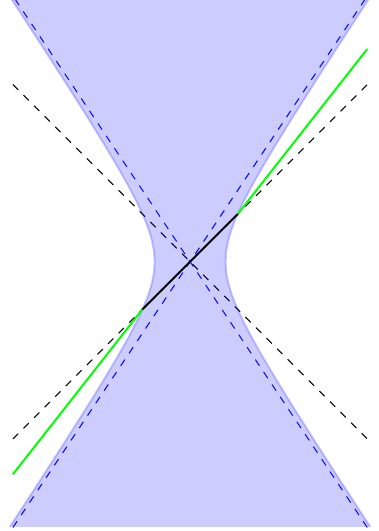
Figure 13. Construction of a causal curve that traverses from the left to the right CFT. The blue shaded region represents the projection of the brane onto the boundary, while the green and black segments are the projections of curves γ I , γ II and γ III . The green segment begins at an early time at the boundary, and extends slowly into the bulk. The black segment is at fixed z = z ∗ . z ∗ is chosen as described in the main text to be outside the brane. The green segment should be adjusted to attach smoothly onto the black one. The second green segment extends slowly towards the